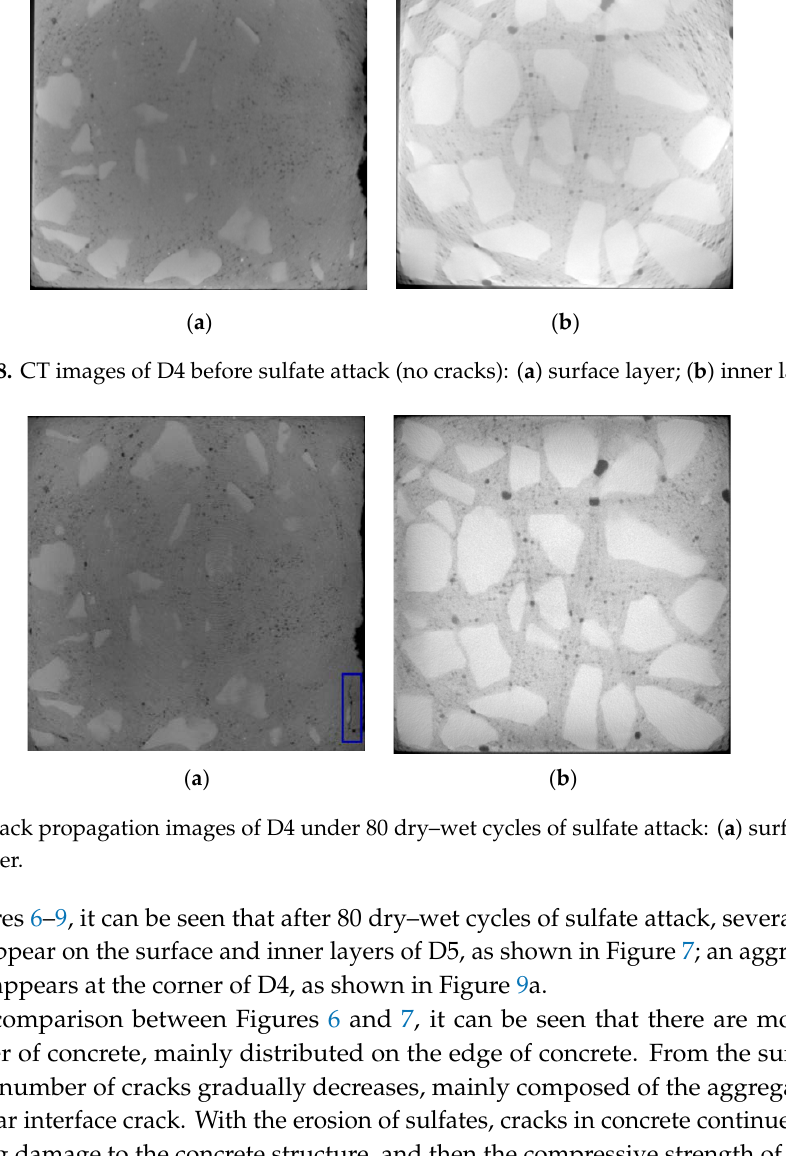
Figure 10. T 2 spectrum distribution of concrete soaked in Na 2 SO 4 solution: ( a ) J5; ( b ) J4.